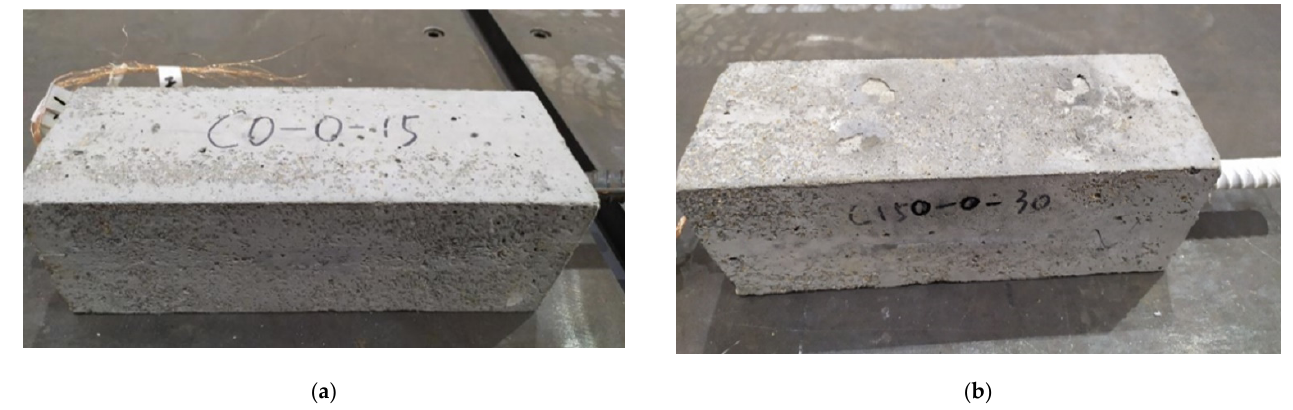
Figure 3. A freeze–thaw specimen: ( a ) After 15 freeze–thaw cycles; ( b ) After 30 freeze–thaw cycles.